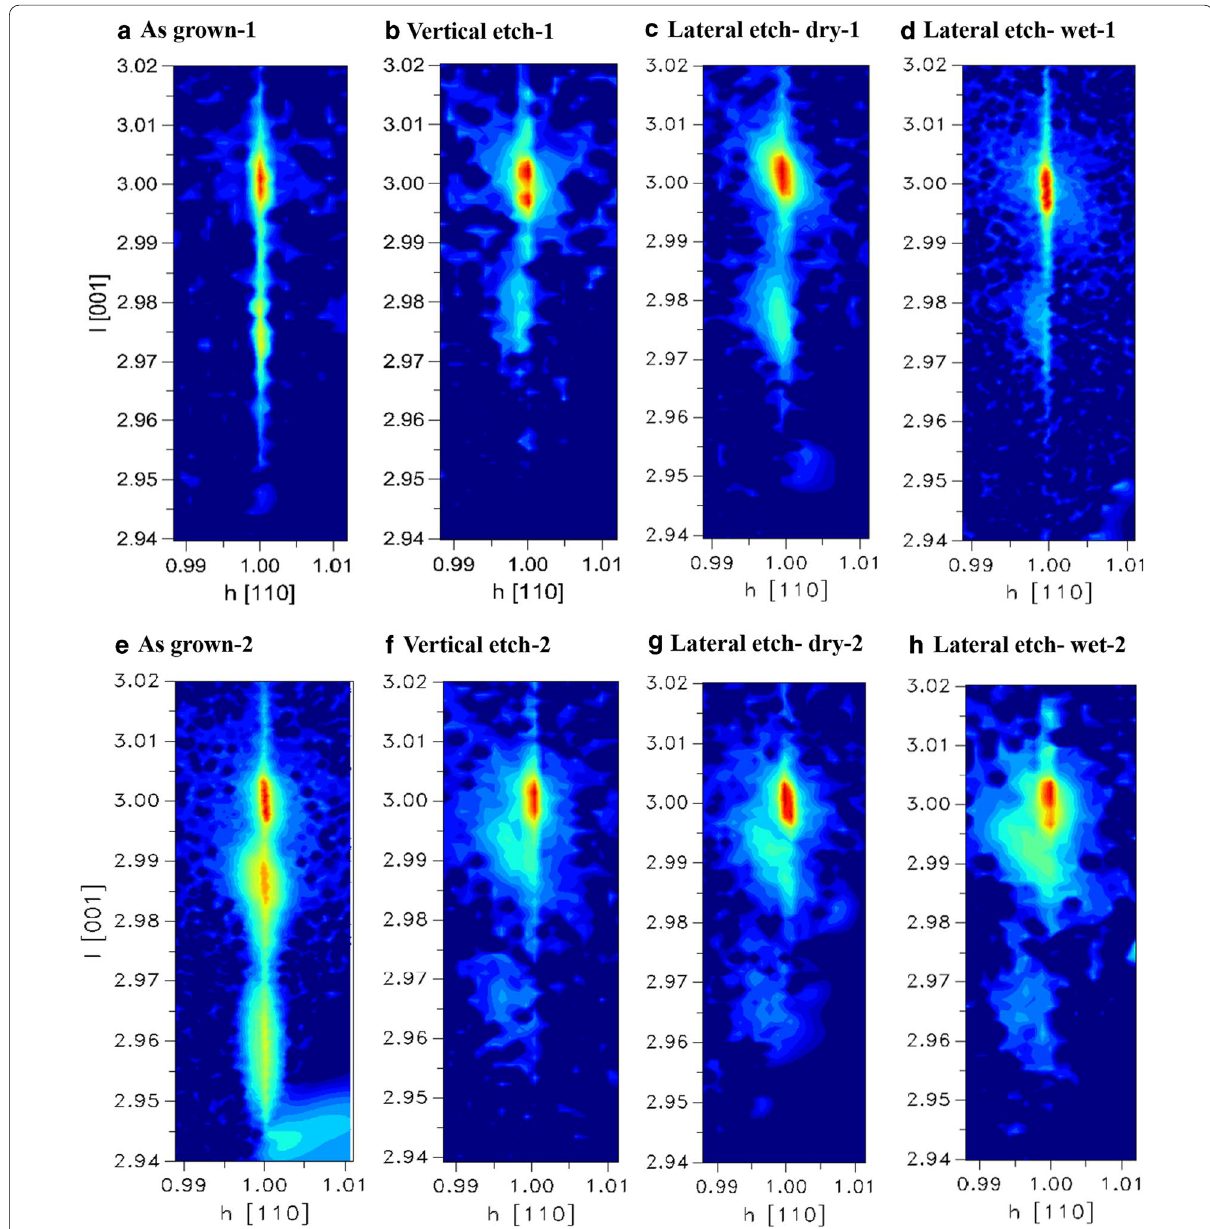
Fig. 9 HRRLMs of P-doped Si/Si 0.86 Ge 0.14 /P-doped Si MLs with 5 nm spacer layer (sample-1) in a – d , and P-doped Si 0.93 Ge 0.07 /Si 0.78 Ge 0.22 /P-doped Si 0.93 Ge 0.07 MLs (Sample-2) in e – h . The two mappings both have four panels: as grown, after vertical etch, lateral wet etch of HF (6%)/H 2 O 2 (30%)/